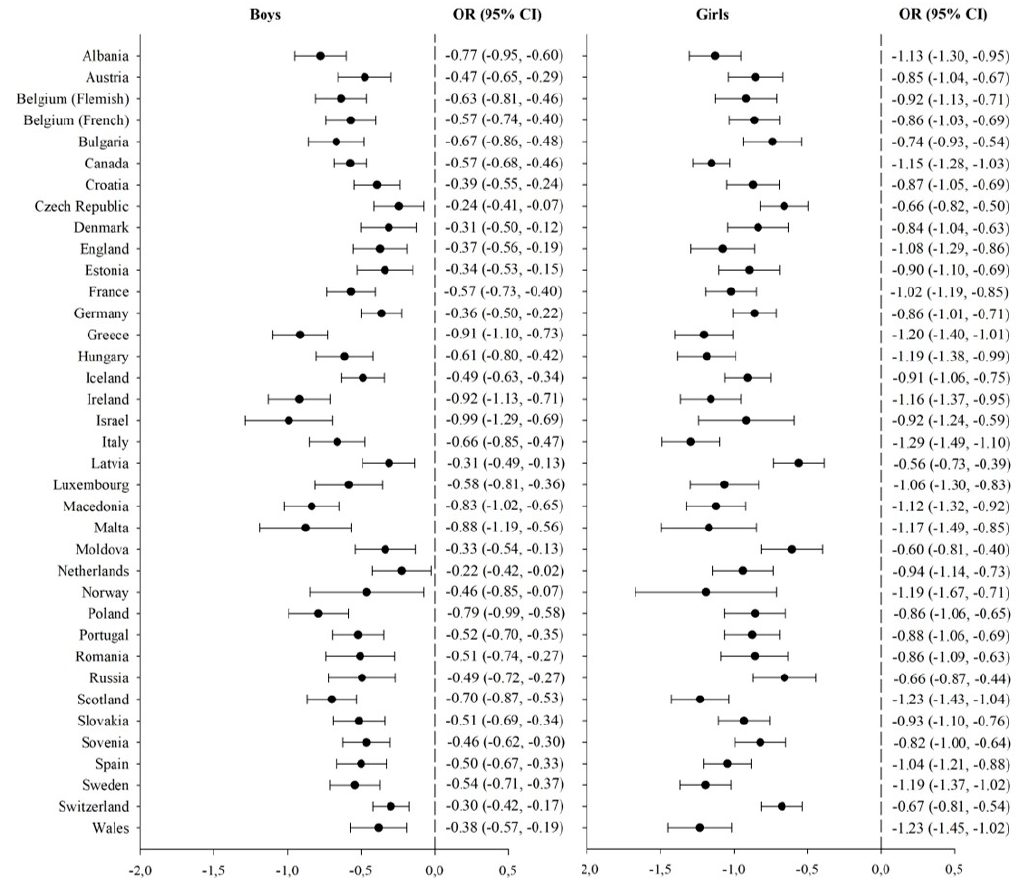
Figure 1. Relationship between psychosomatic symptoms and a healthy lifestyle score, by sex and 21 country. 22